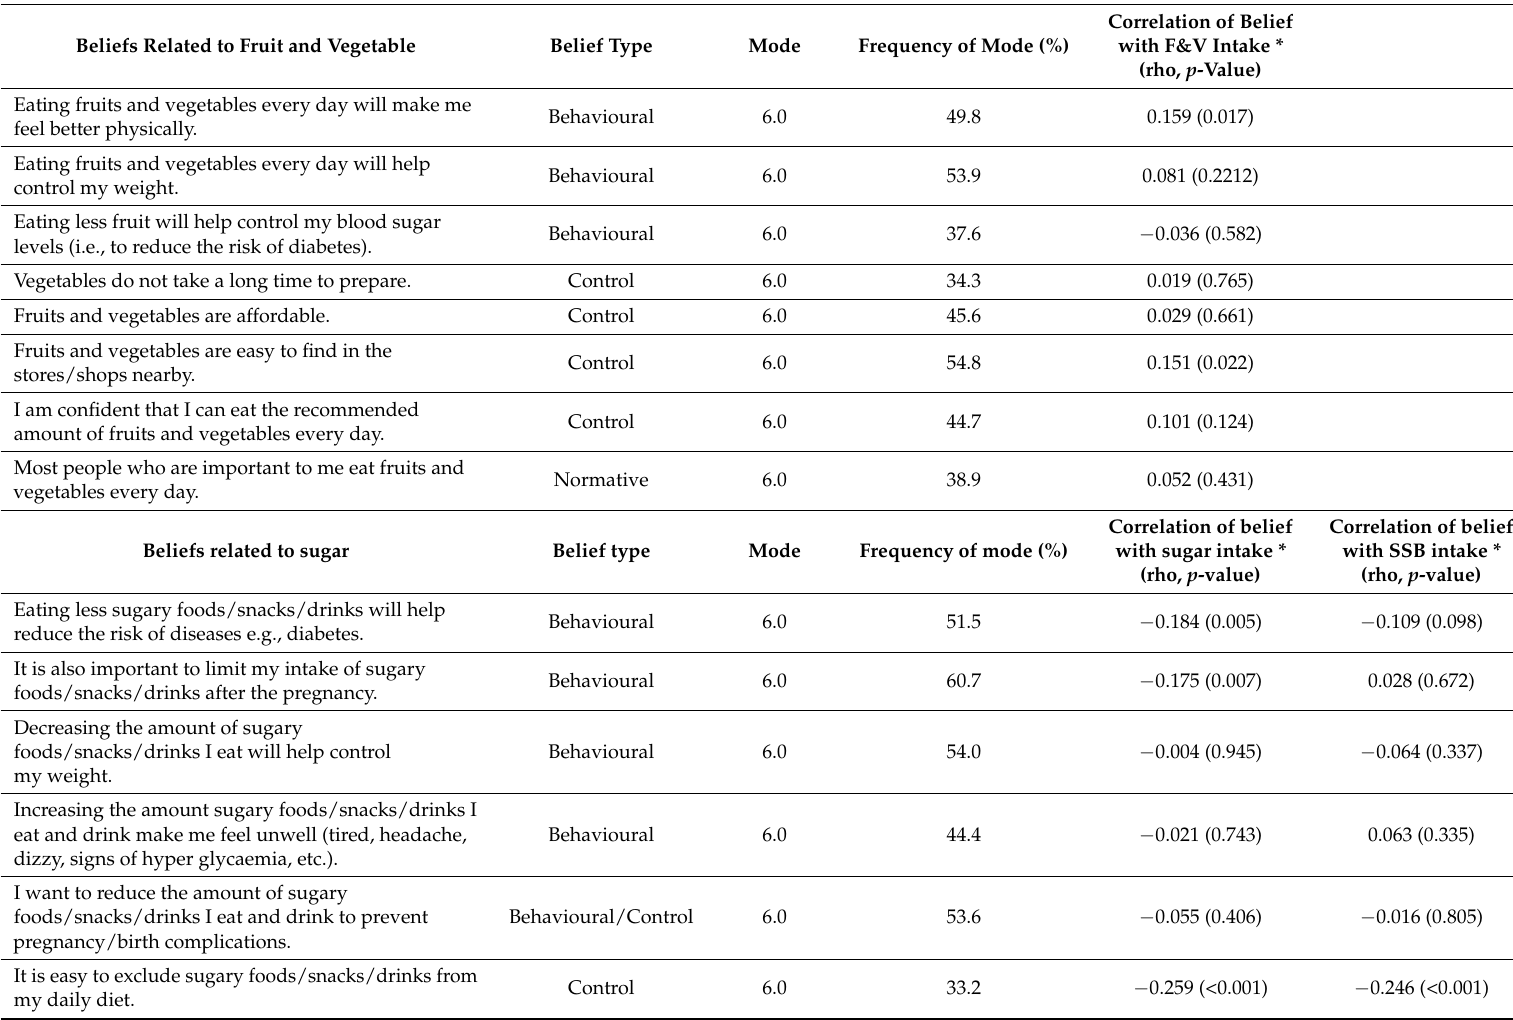
Table 5. Beliefs associated with the intake of Fruits and Vegetables and